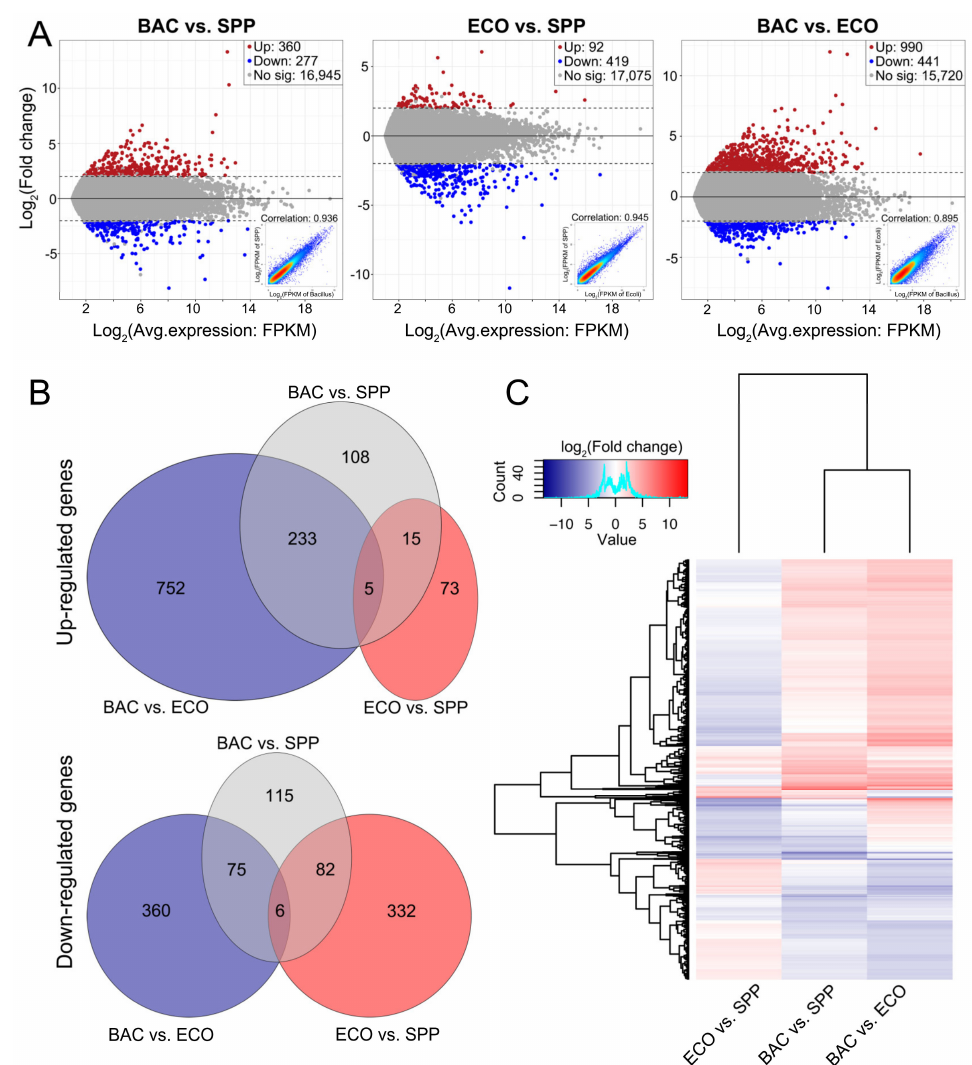
Figure 3. Visualization of gene expression changes of T. thermophila between any two of the treatments. ( A ) MA plots for the average expression and fold changes in log scale to visualize the change in gene expression and distribution of comparisons among three treatments for all 19,831 transcripts. The colored data points indicate the upregulated (in red), downregulated (in blue) and unaltered transcripts (in grey), respectively; scatter plots for each comparison of FPKM for all transcripts (inset). ( B ) Three-way Venn diagrams display the number of up- and downregulated genes that are shared and unique between these treatments. ( C ) Hierarchical cluster analysis performed on the profiles of 1919 di ff erentially expressed transcripts, and the heatmap of log 2 (fold change) showed a distinct expression pattern in ECO vs. SPP relative to the other two